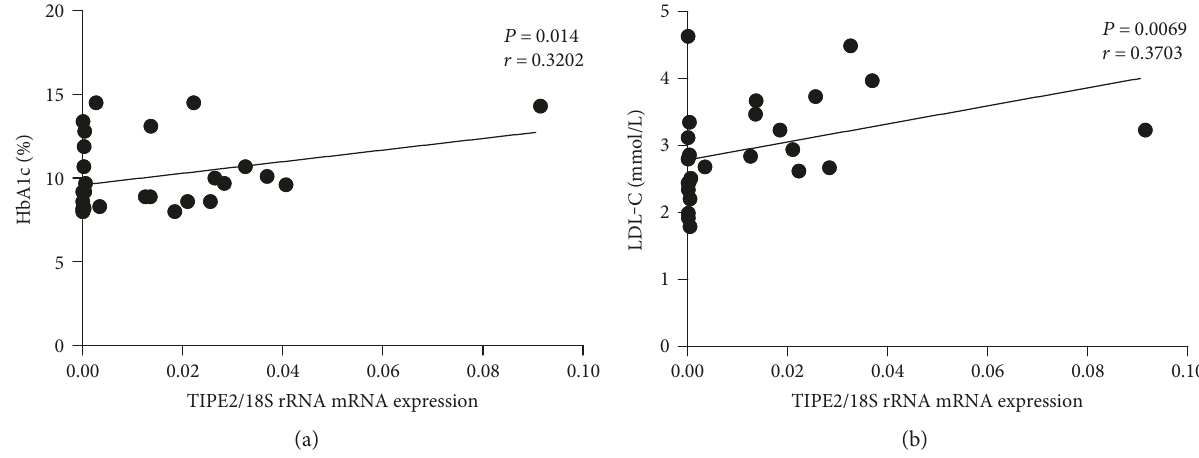
Figure 5: Correlation analysis between the mRNA levels of TIPE2 and the serum concentrations of HbA1c and LDL-C in T2DM patients. TIPE2 mRNA expression was determined by RT-PCR, and the serum concentrations of HbA1c and LDL-C in T2DM patients were determined by HPLC and standard colorimetric-based enzymatic kits, respectively. Pearson ’ s correlation analysis was done. A positive correlation was found between TIPE2 mRNA and HbA1c in T2DM patients (a). There was a tendency for a positive correlation between the mRNA levels of TIPE2 and the serum concentrations of LDL-C in T2DM patients (b). Every point shows information from one